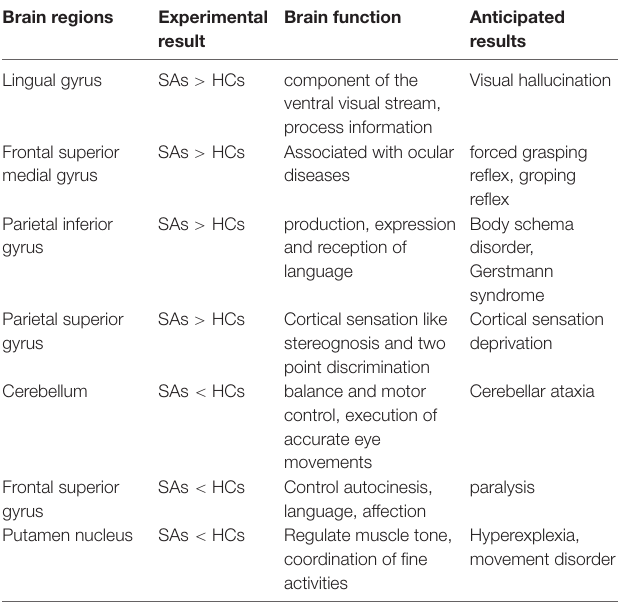
TABLE 4 | Brain regions alternation and its potential impact. Brain